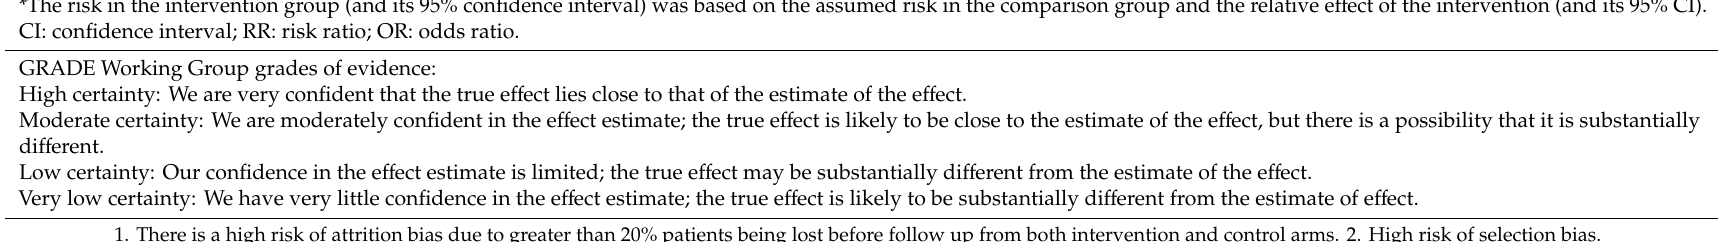
Table 3. Optimizing inter-pregnancy interval—Education + provision of contraception + involvement of male partner vs. education